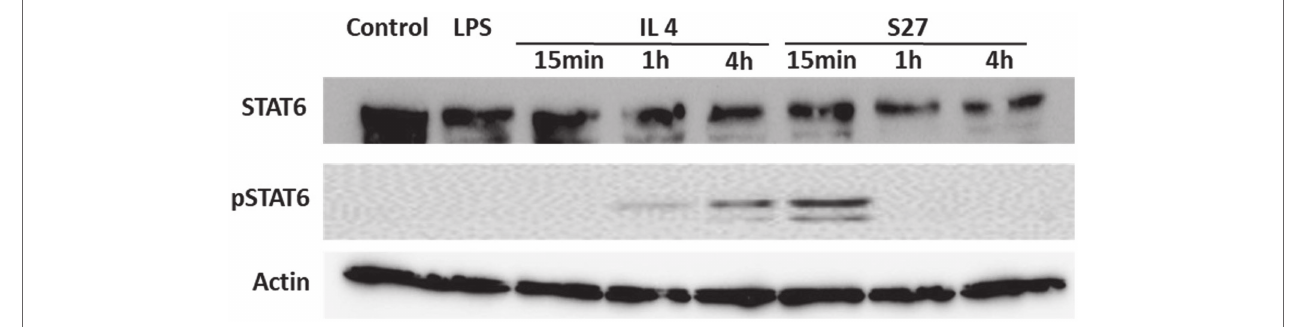
FIGURE 8 | Western blot analysis of the expression of STAT-6 and pSTAT-6 in PBMMs treated with IL-4 or S27. Cell lysates were prepared from PBMMs treated with IL-4 (15 ng/ml) or S27 (100 ng/ml) for 15 min, 1 h and 4 h. Cell lysates of untreated PBMMs or PBMMs treated with LPS (100 ng/ml) for 15 min served as negative controls. B-actin was used as a loading control. Data shown is representative of 3 replicates.